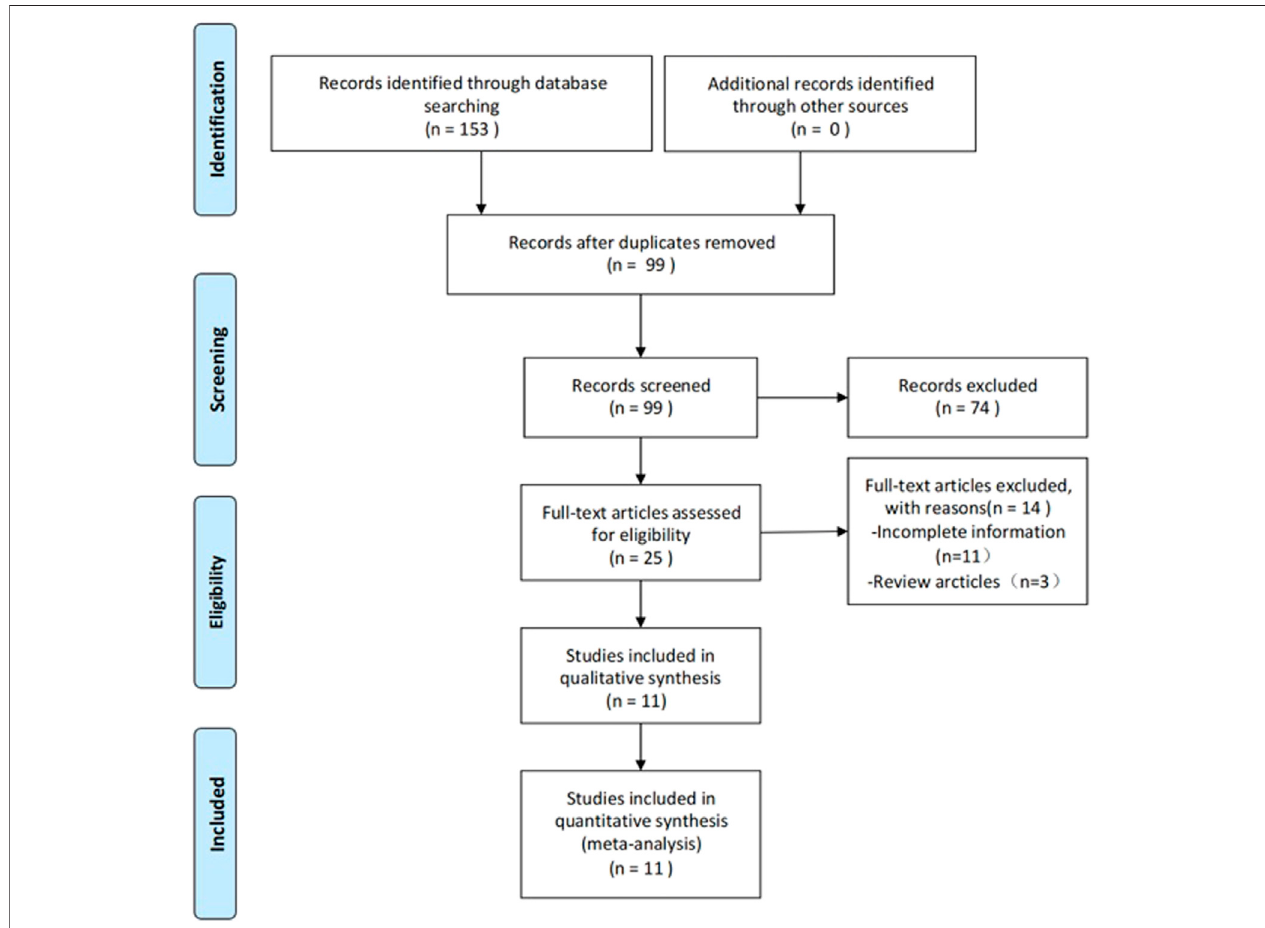
FIGURE 1 | PRISMA fl ow chart summarized the literature search and number of included